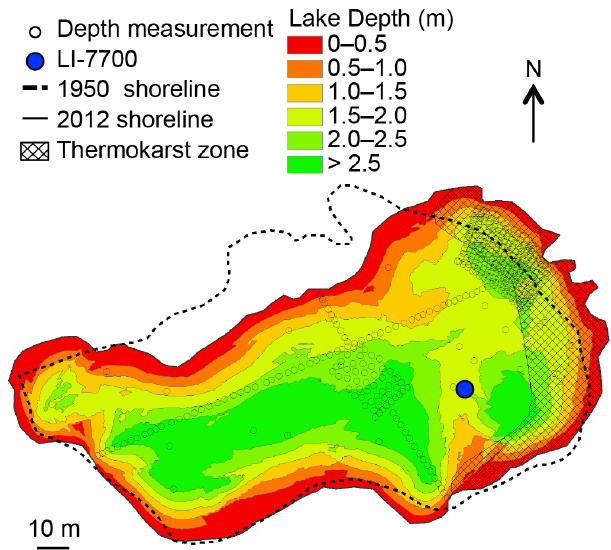
Figure 2. Map of Goldstream Lake showing the location of the LI- 7700 Open Path Methane Analyzer used to measure atmospheric CH 4 concentrations, locations of depth measurements, 0.5m bathy- metric isolines, shoreline locations in 2012 and l950, and the thermokarst zone, characterized by eastward thermokarst expansion and high ebullition